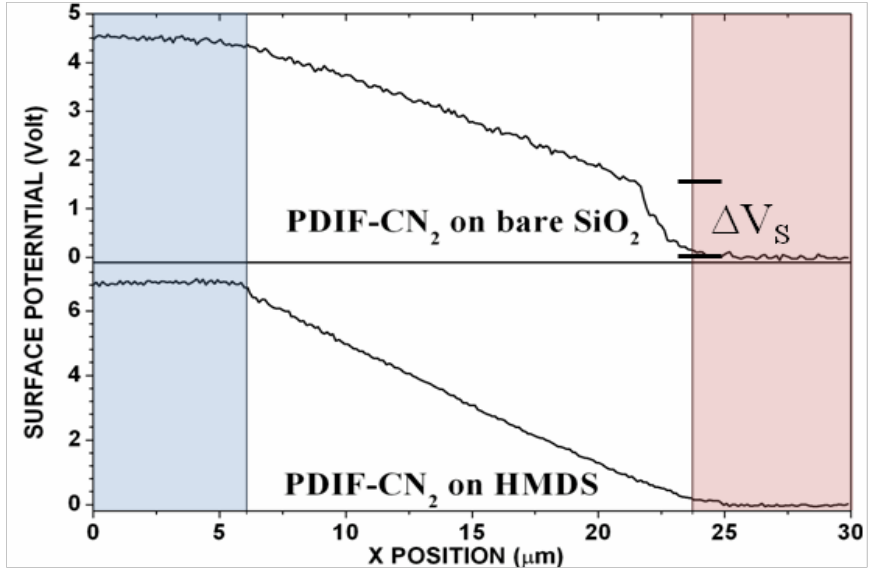
Figure 3. Surface potential profile measured by scanning Kelvin probe microscopy (SKPM) across the channel. The colored areas indicate drain (blue light) and source (red light)